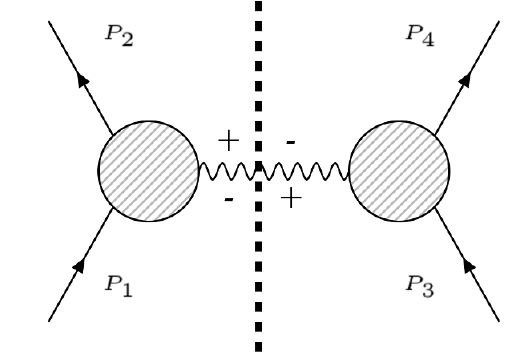
Figure 2 . A one photon/graviton exchange process. In the HCL the internal particle is on-shell and the two polarizations need to be